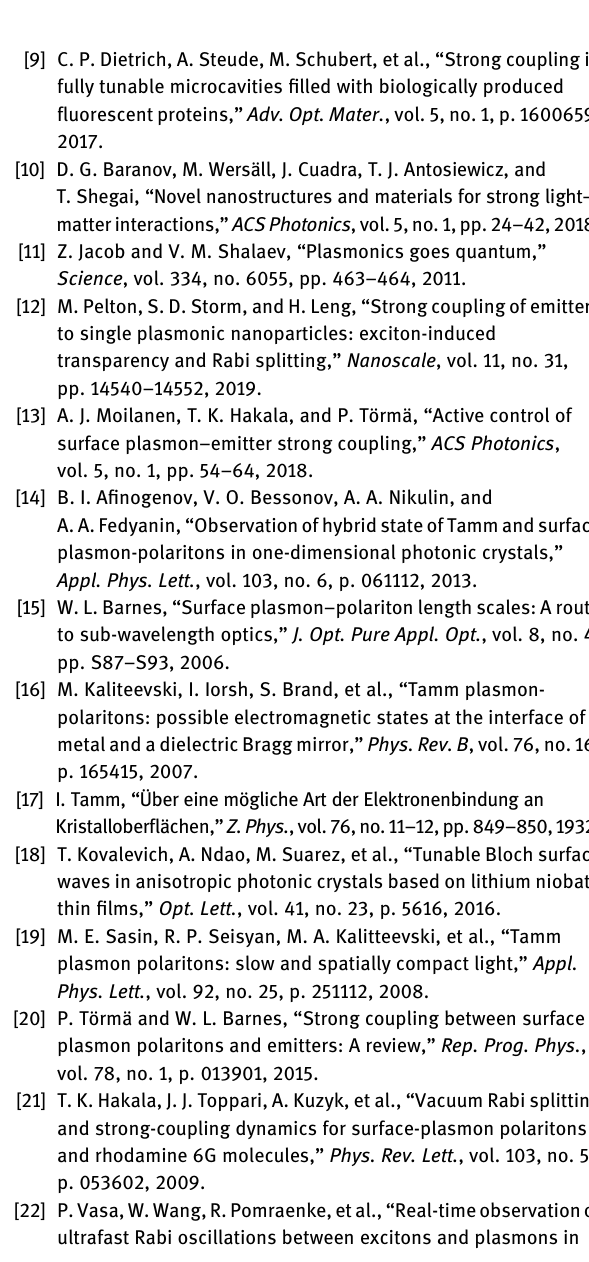
the desired spectral range. If one component is excited at resonant wavelength, the other is also present and can be controlled by strong coupling between TPP and SPP. The energy conversion between TPP and SPP shows potential applications of hybrid TPP-SPP modes for integrated pho- tonic devices.